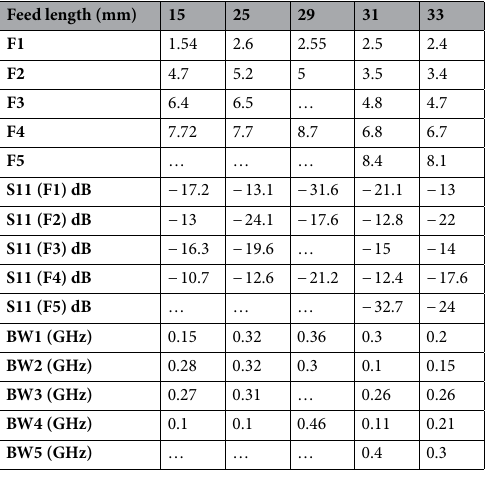
Table 7. Electrical properties of Antenna2 with respect to a feedline length as a parameter.